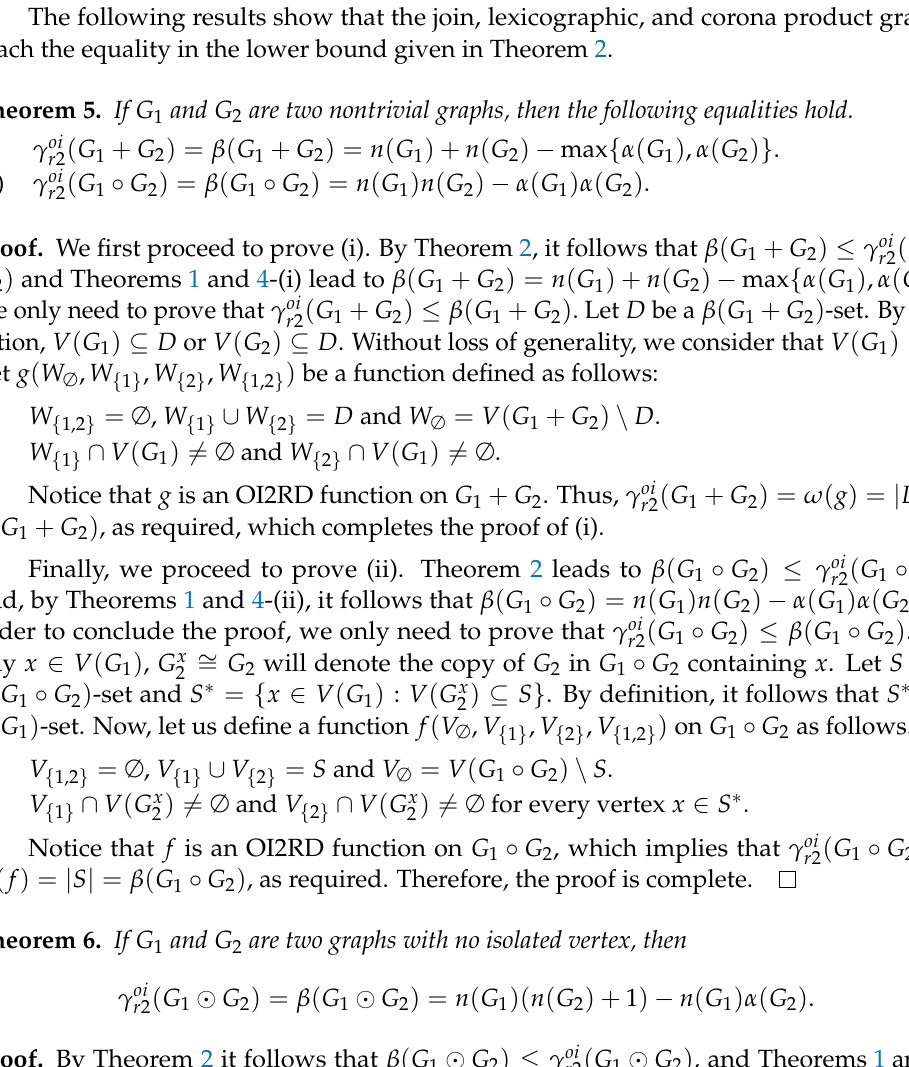
( P (cid:12) P ) -function, 3 4 r 2